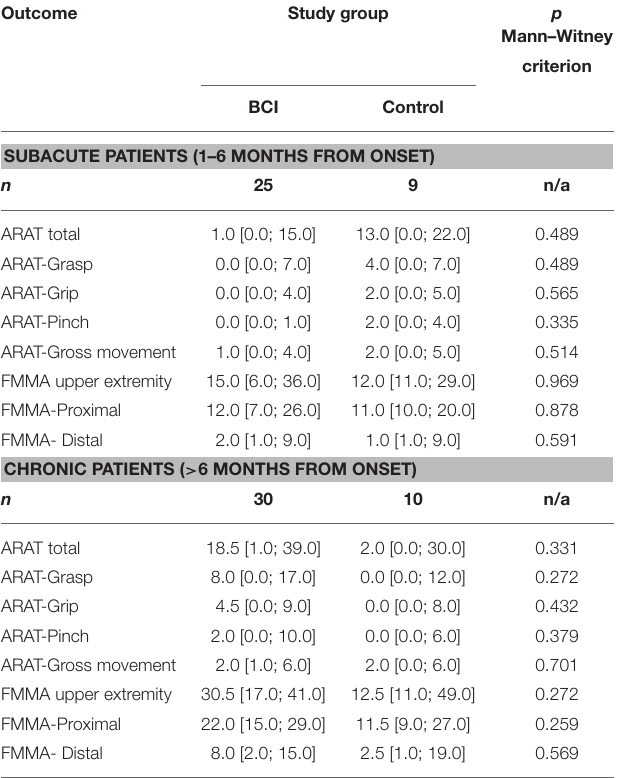
TABLE 2 | Baseline ARAT and FMMA scores by study group and stroke period. Outcome